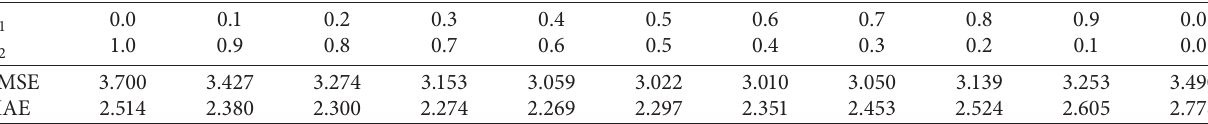
Table 3: The weight coefficients correspond to the evaluation metrics of the model.